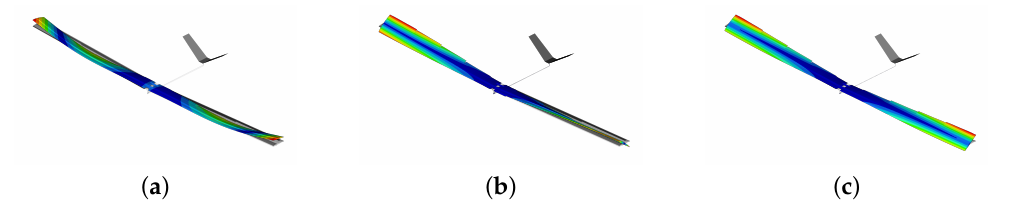
Figure 13. Natural eigenmodes. ( a ) Natural mode-9, symmetric bending; ( b ) Natural mode-11, antisymmetric torsion; ( c ) Natural mode-12, symmetric